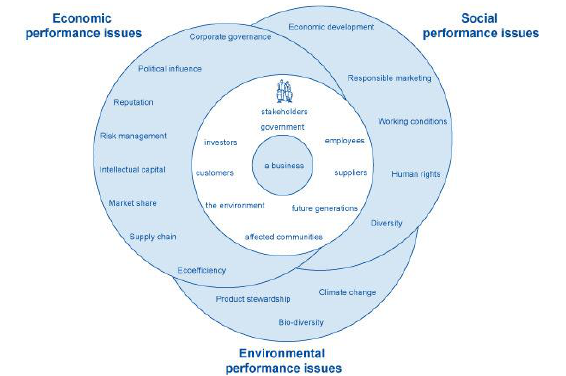
Figure 1: Economic, Social and Environmental Performance